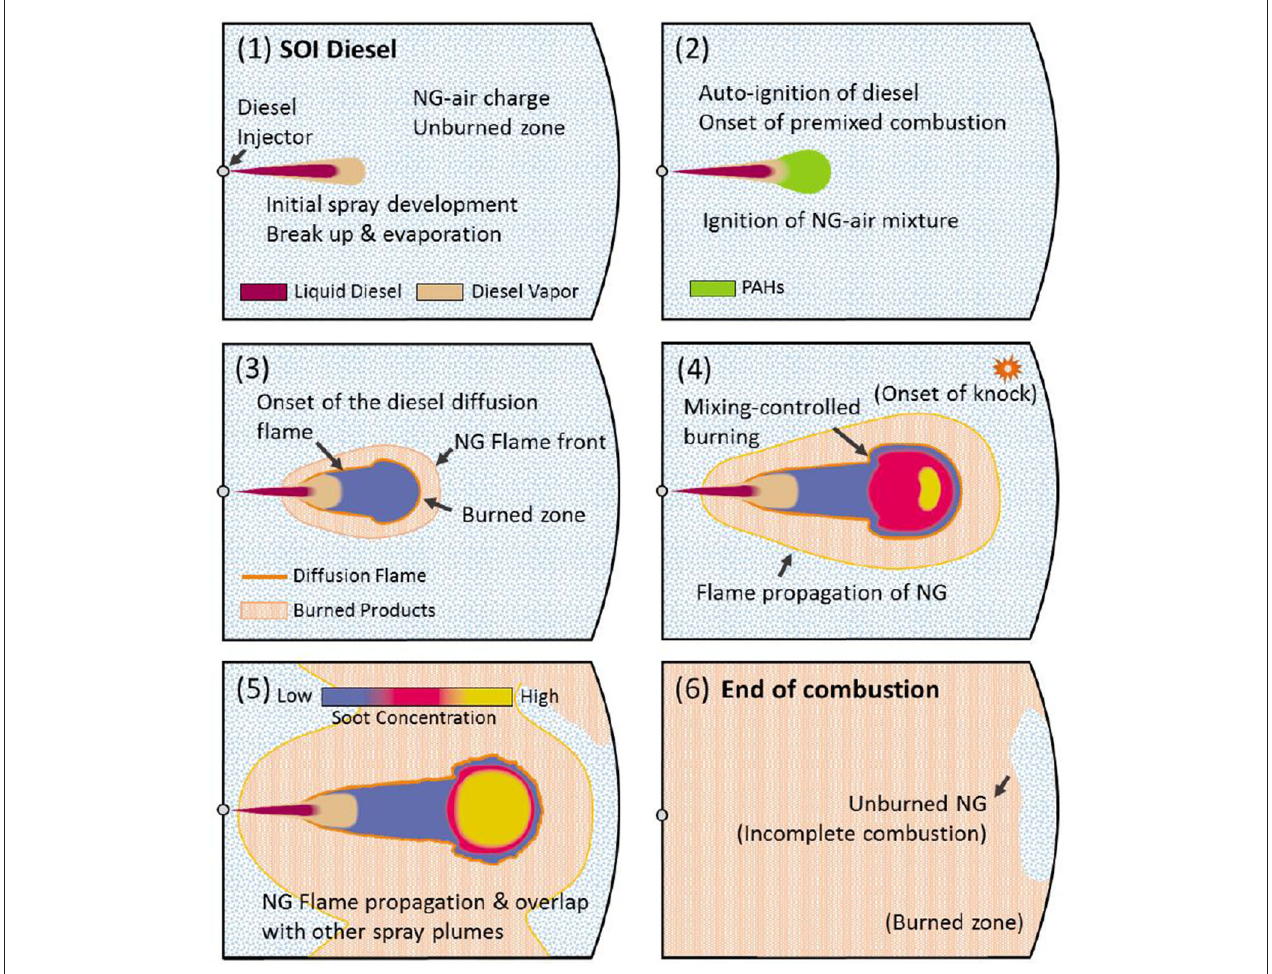
FIGURE 2 | A time-lapse illustration of dual-fuel combustion process. Conceptual spray evolution images are from the seminal paper by Dec (1997), SAE 970873.